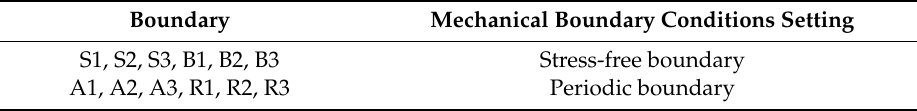
Table 1. Boundary conditions of the 2D simulation